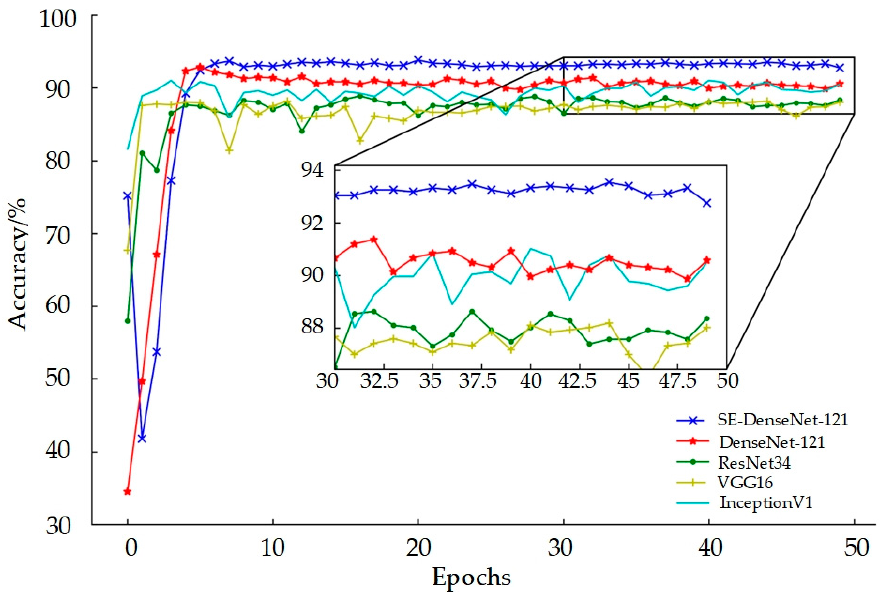
Figure 11. Accuracy variation curves of different models on the validation set with MFCC + ∆ MFCC as parameters.